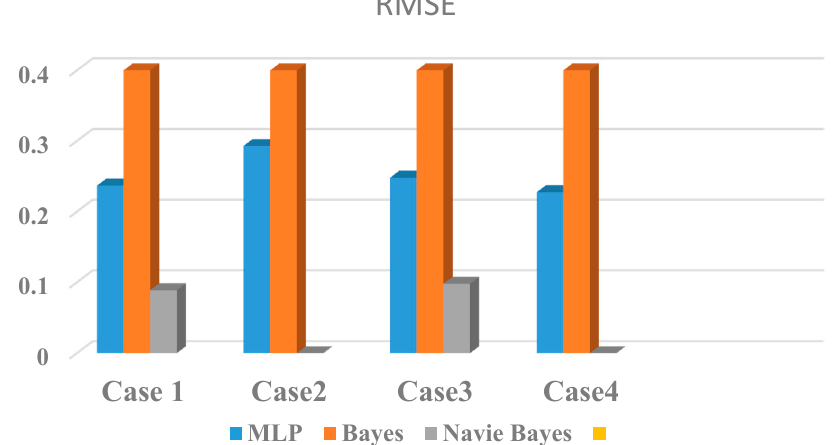
Figure 17. RMSE comparison of various classifiers.